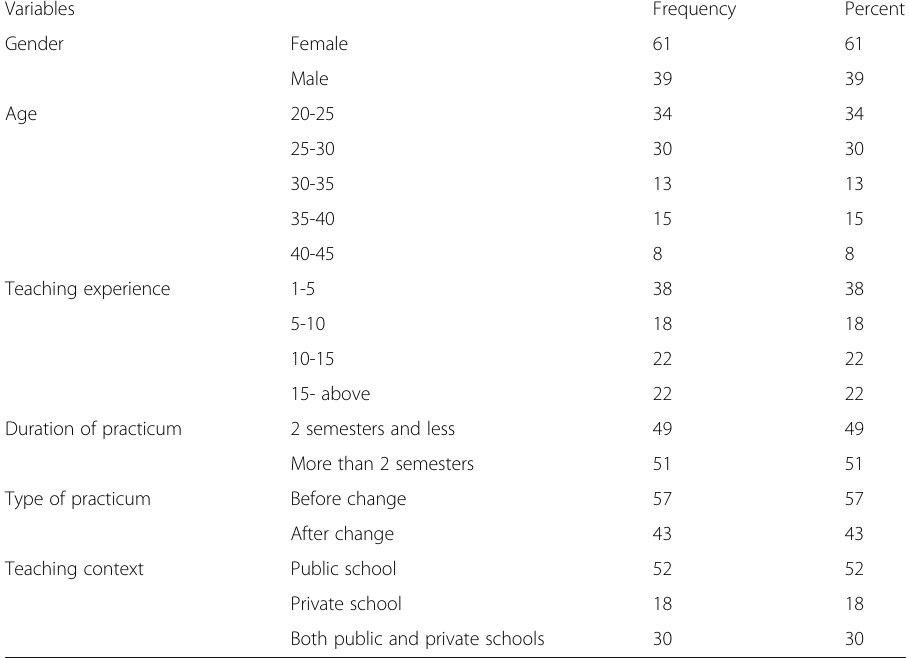
Table 1 Demographic information of the participants